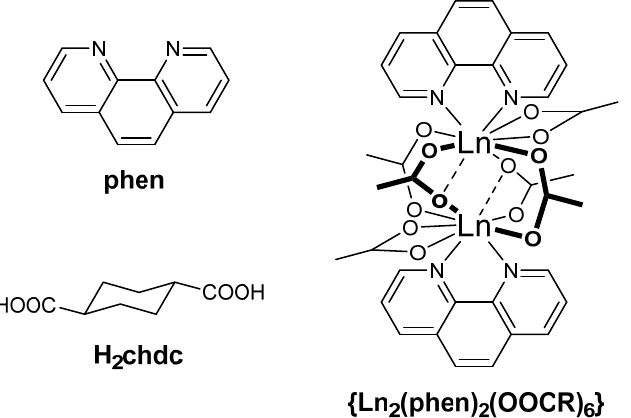
Figure 1. Structural formulae of the used ligands and secondary building unit in 2 Ln .